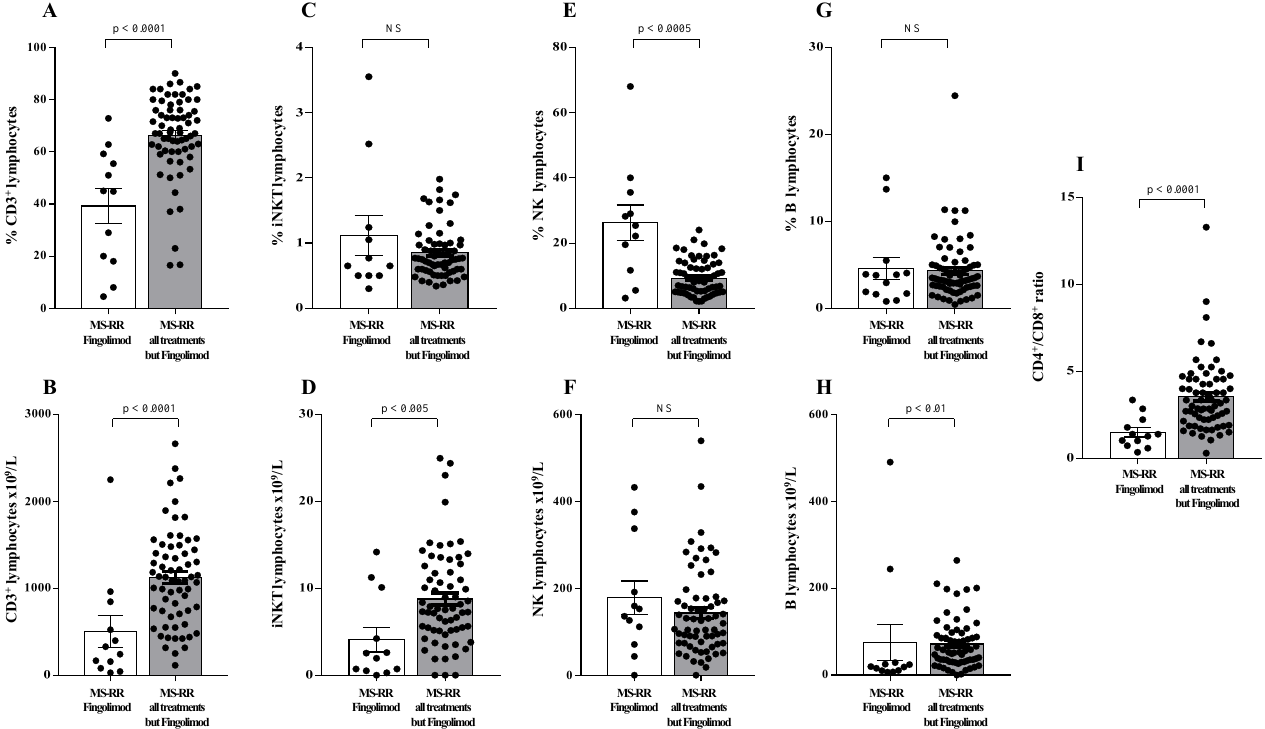
Figure 2. Immune profile of MS-RR individuals grouped according to the administered treatment. White column with black dots represents the MS-RR individuals undergoing fingolimod therapy; grey column with black dots indicates the MS-RR subjects undergoing all treatments, except fingolimod. ( A , C , E , G ) Percentage of circulating CD3 + , iNKT, NK, and B lymphocytes, respectively. ( B , D , F , H ) Number of circulating CD3 + , iNKT, NK, and B lymphocytes, respectively. ( I ) CD4 + /CD8 + ratio. Statistical evaluation of data was performed by means of the Mann–Whitney